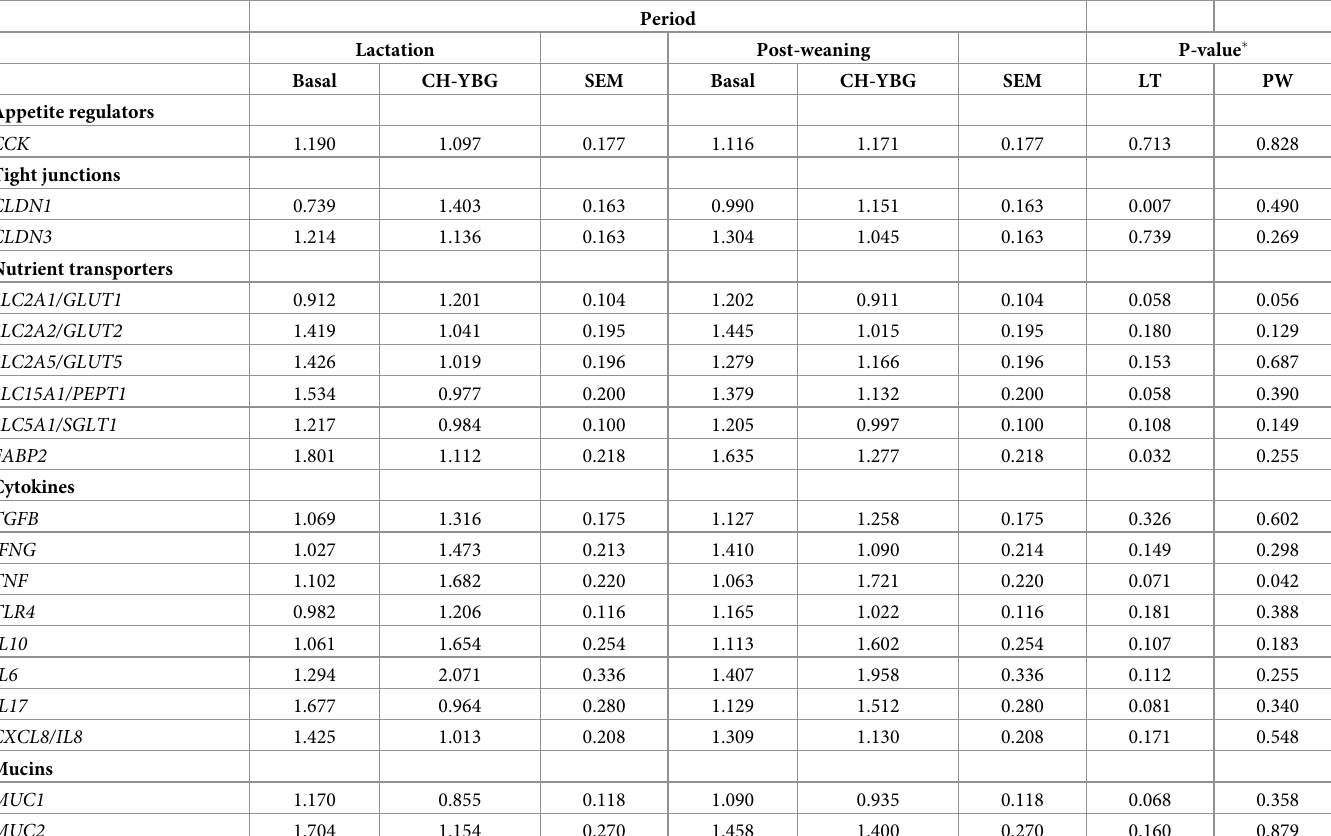
Table 12. Effect of supplementation of CH-YBG during gestation/lactation and/or post-weaning on the expression appetite regulators, tight junctions, nutrient transporters, cytokines and mucins in the jejunum. (least-square mean values with their standard error of